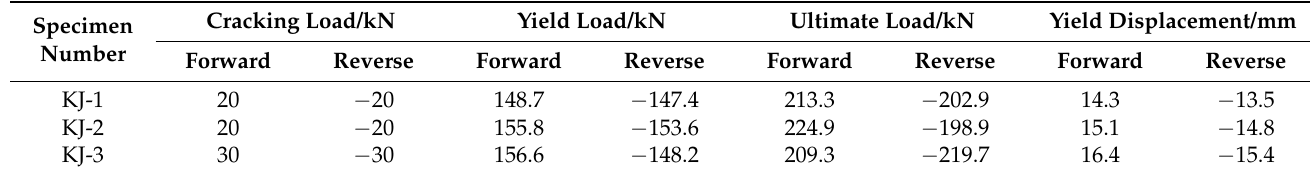
Table 7. Strength index of various stages.